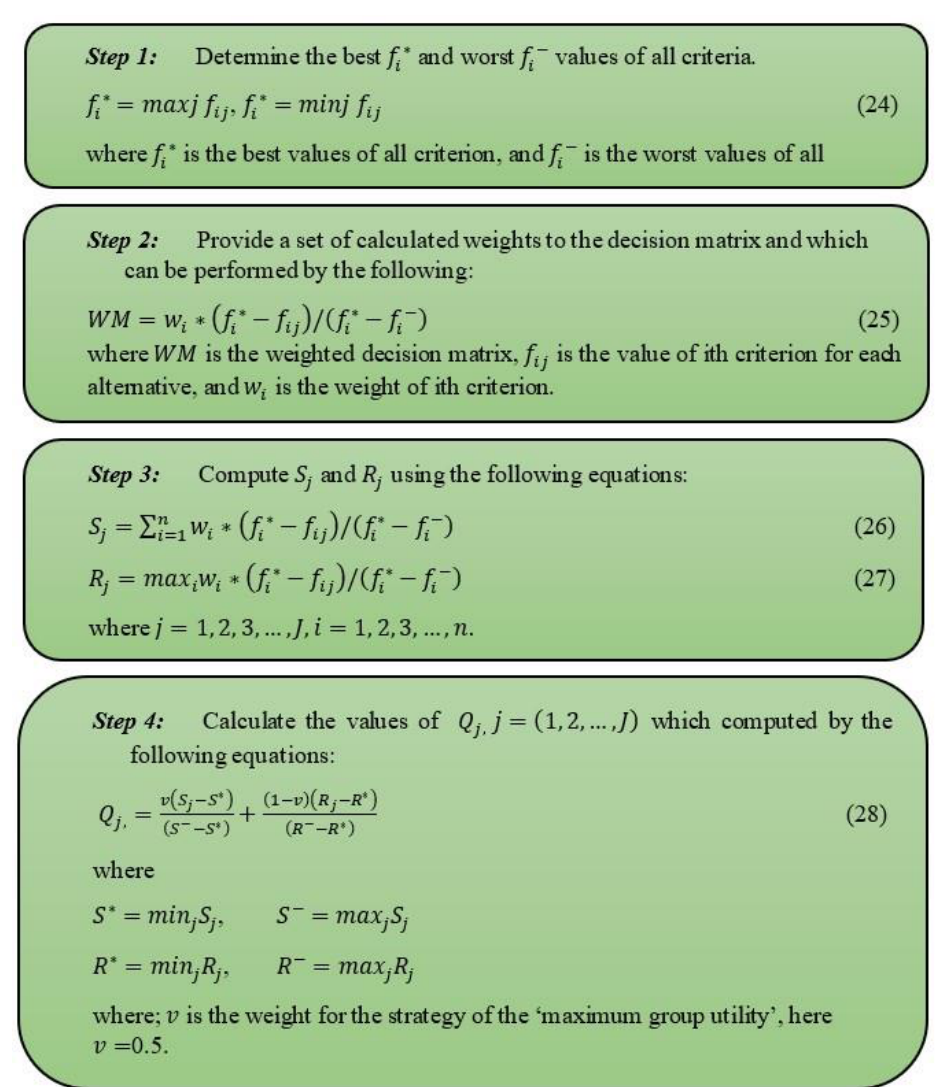
Figure 8. The mathematical steps of the VIKOR method.